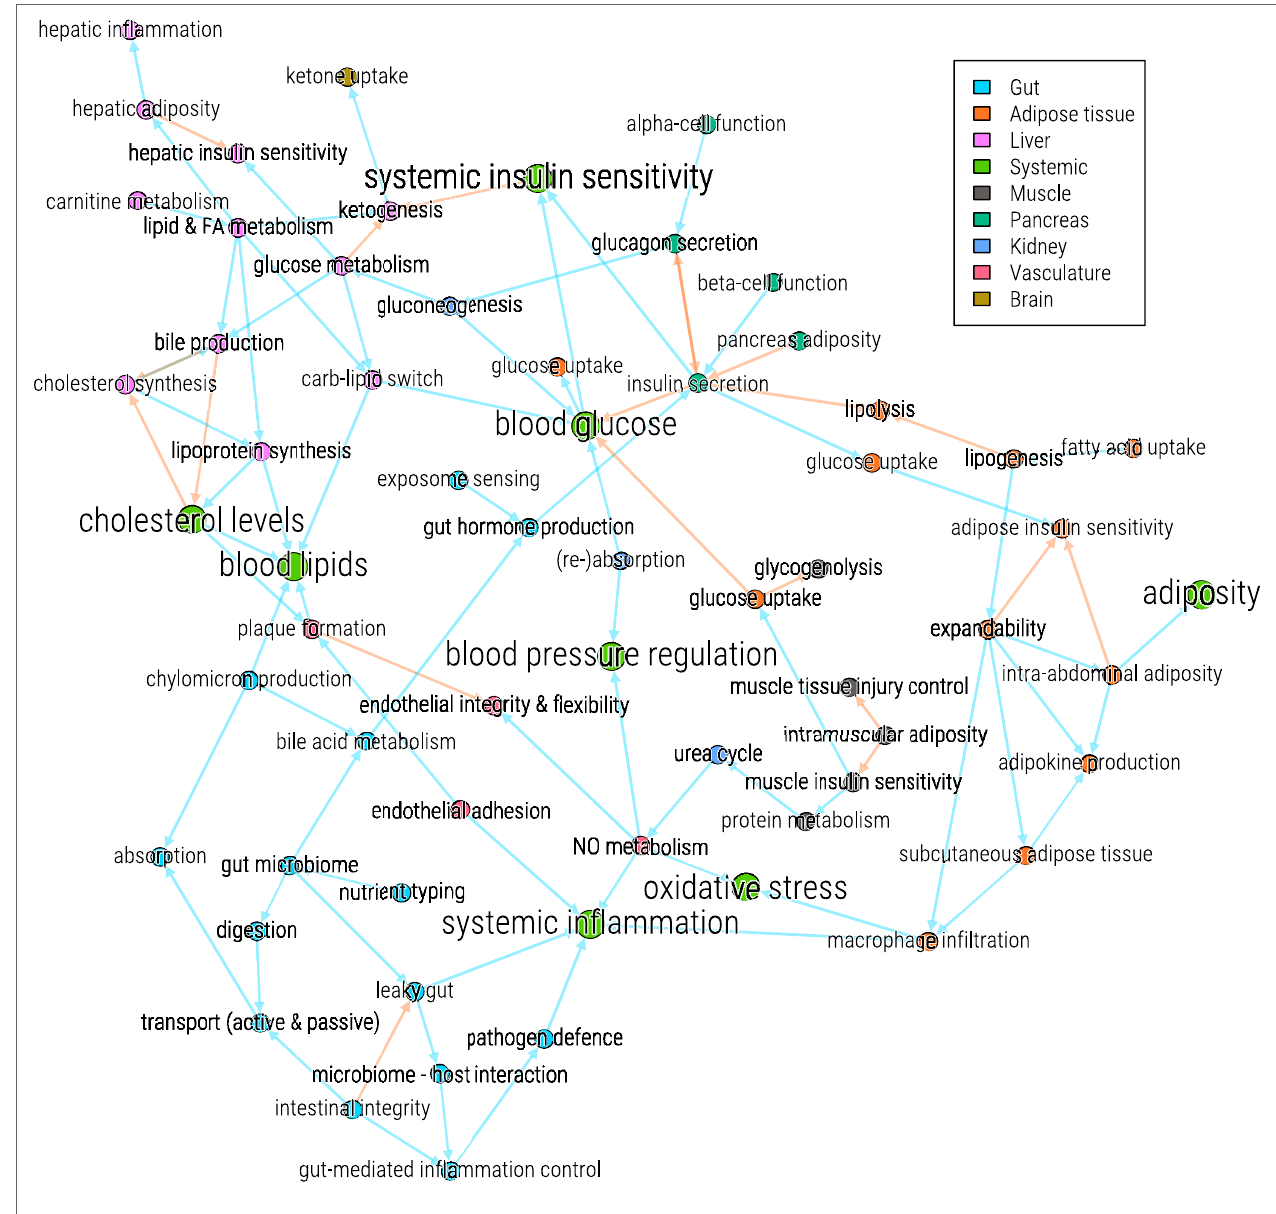
FiGURe 1 | Systems view on processes involved in glucose control and type 2 diabetes. The processes (nodes) are colored according to their involvement with organs (see legend). Blue arrows (edges) indicate a positive effect of one process on another, red arrows indicate a negative